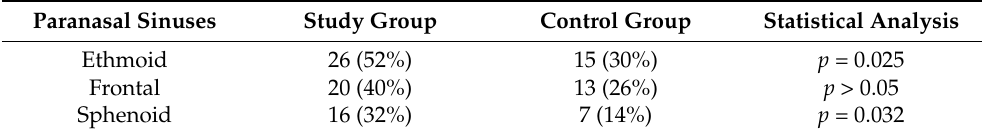
Table 1. Sinus involvement (apart from maxillary